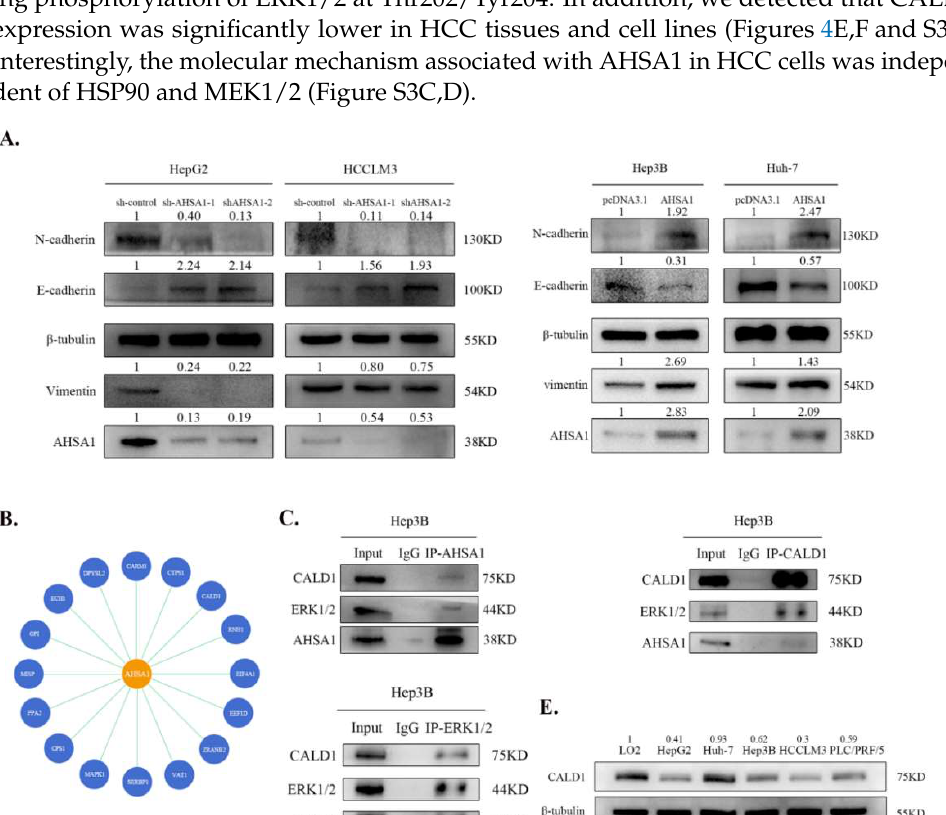
Figure 4. AHSA1 promoted the phosphorylation and inactivation of CALD1 by phosphorylation of ERK1/2 ( A ). EMT markers were analyzed by Western blot by changing AHSA1 expression in HCC cells. ( B ). Proteins that may interact with AHSA1 were obtained by qualitative mass spectrometry. ( C ). AHSA1-ERK1/2-CALD1 was analyzed using Co-IP of the Hep3B cell lysate and Western blot. ( D ). Protein levels of downstream molecules in HCC cells with AHSA1 knockdown or overexpres- sion were analyzed by Western blot. ( E ). CALD1 protein expression in HCC cells lines and normal immortalized liver epithelial cells were analyzed. ( F ). Representative IHC images of CALD1 expres- sion in cancer and adjacent tissues from HCC patients. The uncropped blots are shown in Supple- mentary Materials. 3.5. ERK1/2 Phosphorylation Inhibitor Reversed the Proliferation and EMT of HCC that was Promoted by AHSA1 Overexpression To verify the effect of ERK1/2 on the promotion of proliferation and EMT by AHSA1 in HCC, rescue experiments were performed with an ERK1/2 phosphorylation inhibitor, SCH772984. Prior studies set forth that SCH772984 inhibits the phosphorylation of resi- dues in the ERK self-activation ring [18]. Within a certain range, CCK-8 results showed that as the concentration of SCH772984 increased, its effect on the survival of Hep3B cells was negligible (Figure S3E). Based on the drug manufacturer’s instructions and related